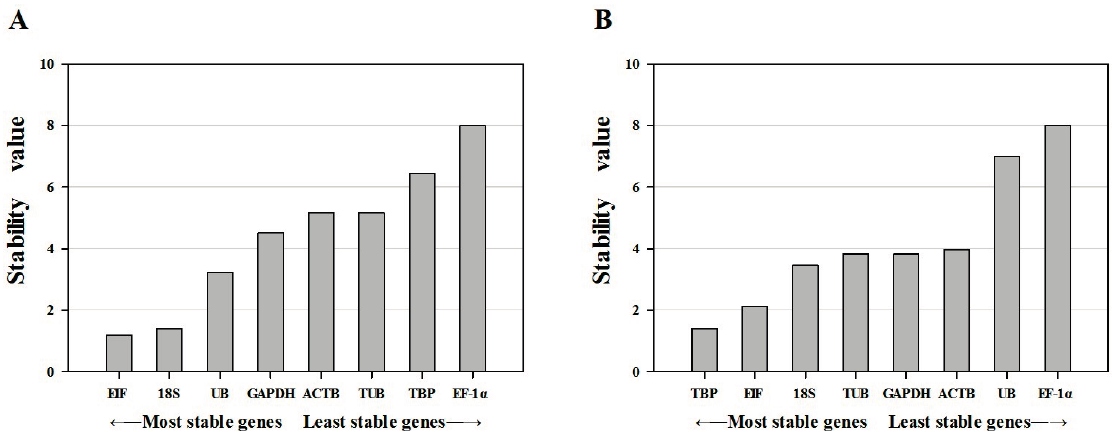
Figure 4. Expression stability of eight candidate reference genes calculated by